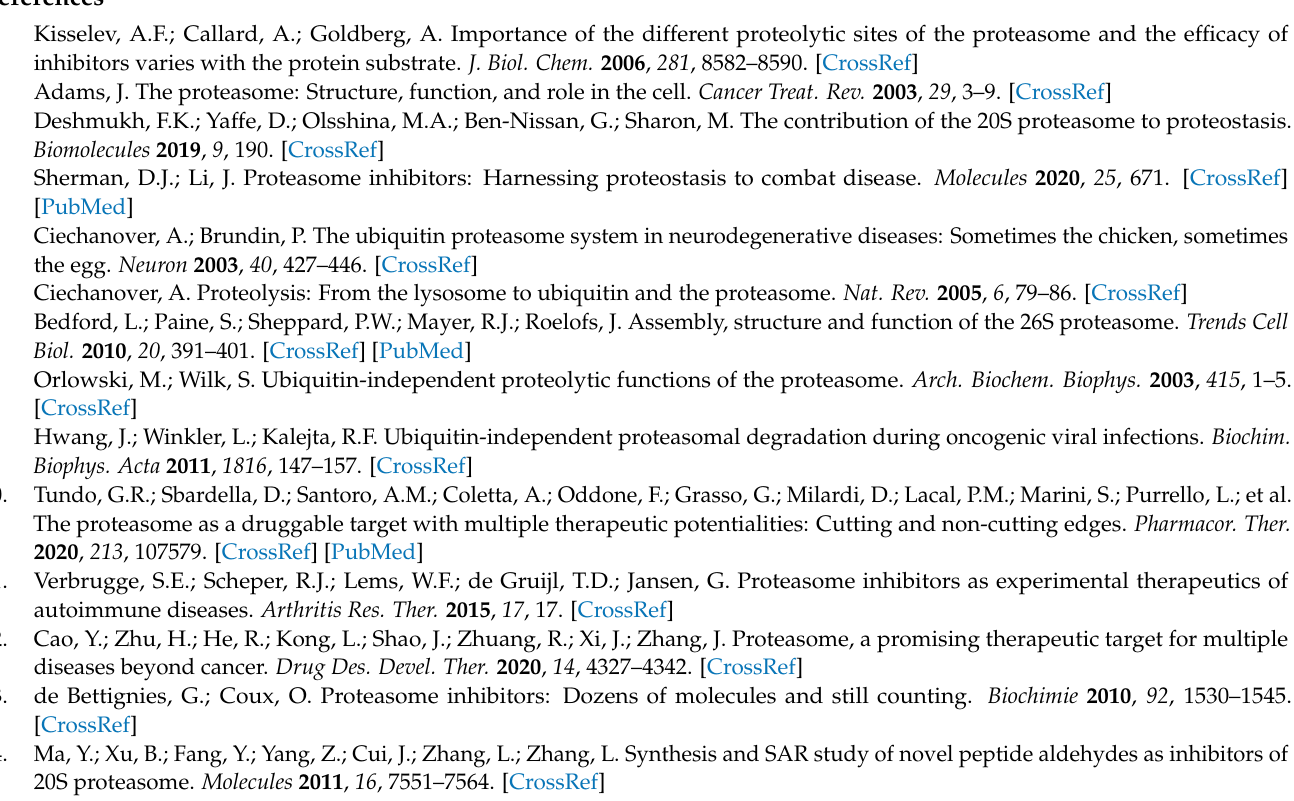
(9:1), Figure S4: HSQC spectrum of Ncp-A2-L in H 2 O:D 2 O (9:1), Figure S5: HMBC spectrum of Ncp-A2-L in H 2 O:D 2 O